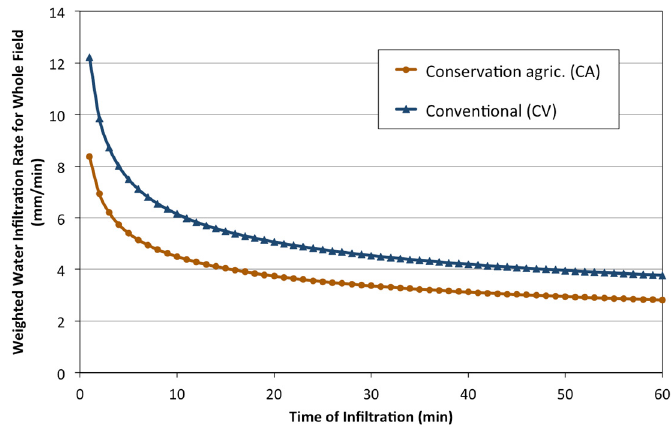
Figure 3. Mean weighted water infiltration rates for whole fields under conservation and conventional agriculture.